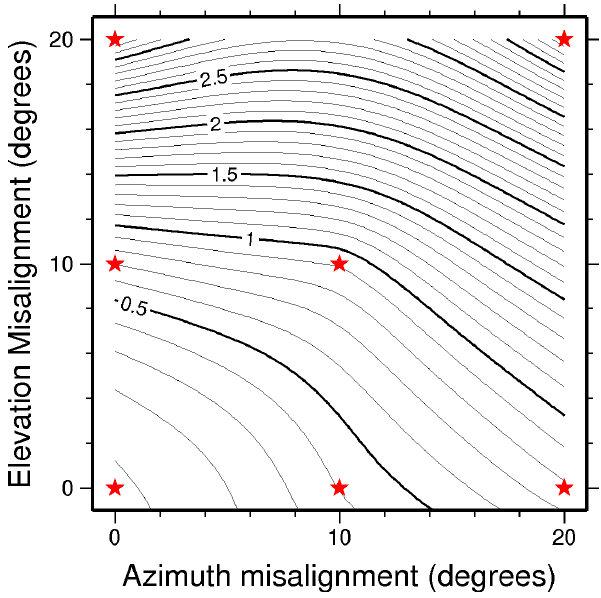
Figure 11. Contour map of RCS loss as a function of azimuth and elevation misalignments. A minimum curvature surface is fitted to the 7 RCS loss measurements from Gunning SAR imagery for the 1.5 m TCR with positive-valued misalignments. The positions in parameter space of the observed data are plotted as red stars. Observed data is taken as the mean of the TSX, CSK and RSAT-2 values. Contour interval is 0.1 dBm 2 with every 0.5 dBm 2 bold and annotated.